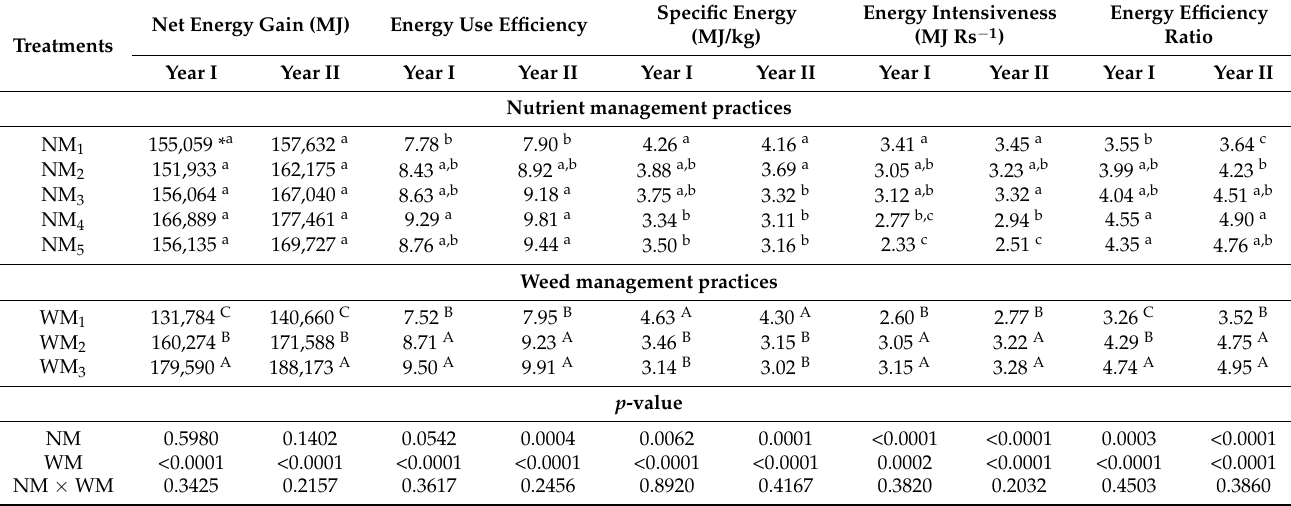
the highest net energy gain. Interaction of nutrient management and weed management practices did not result in any significant variation in net energy gain. The higher net energy gain may be due to a higher yield from the respective management practices [34,38,39]. Table 5. Energy indicators in maize under the rice–maize–green gram cropping system.